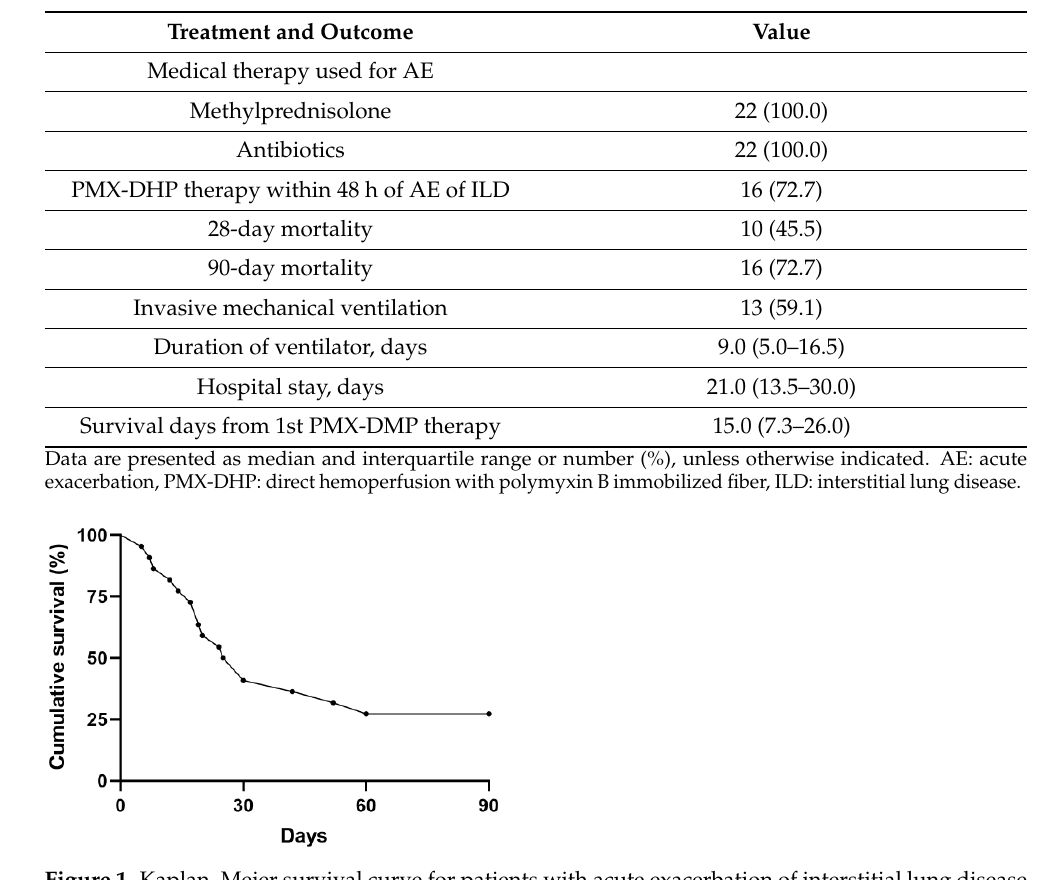
Table 2. Treatment and outcome of the patients.